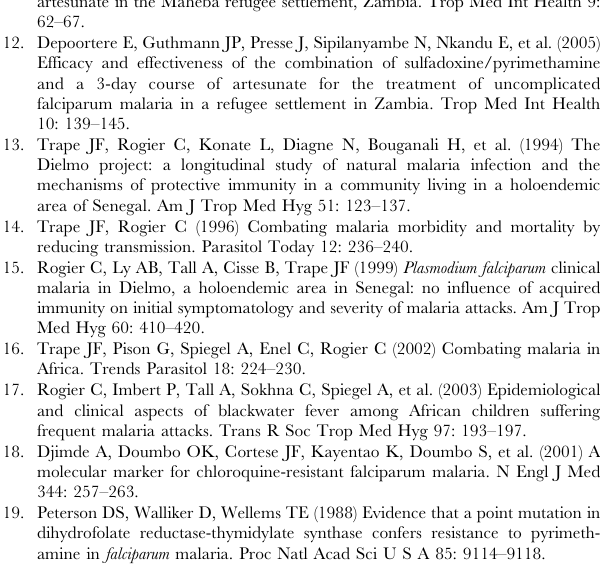
Table S2 Pfcrt intron 4 Microsatellite haplotypes.